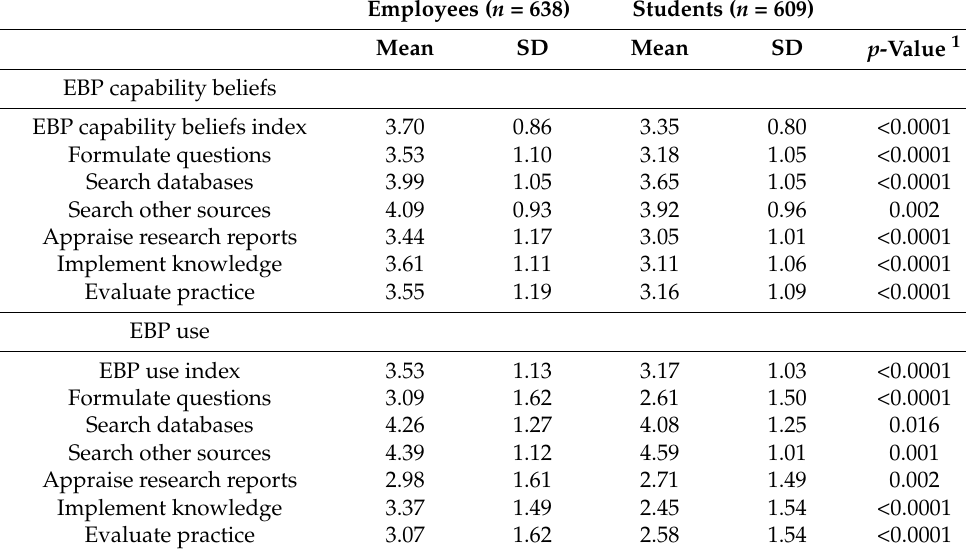
Table 2 depicts the results of the statistical comparison using T tests between employ- ees and students in EBP capability beliefs and use. The employee group rated a mean value of 3.7 on the EBP capability beliefs index, scoring between 3.4 ( Appraise research reports ) and 4.1 ( Search other sources ) on the six EBP activities. The student group rated a mean value of 3.4 on the EBP capability beliefs index, scoring between 3.1 ( Appraise research reports ) and 3.9 ( Search other sources ). The employee group rated a mean value of 3.5 on the EBP use index, scoring between 3.0 ( Appraise research reports ) and 4.4 ( Search other sources ) on the six EBP activities. The student group rated a mean value of 3.2 on the EBP use index, scoring between 2.5 ( Implement knowledge ) and 4.6 ( Search other sources ). The professional groups differed statistically significantly in all items and the two indices (all p < 0.05), with the students scoring lower in all items of EBP use except for Search other sources . Table 2. Comparison of reported evidence-based practice (EBP) capability beliefs and use between employees and students (total n = 1247).